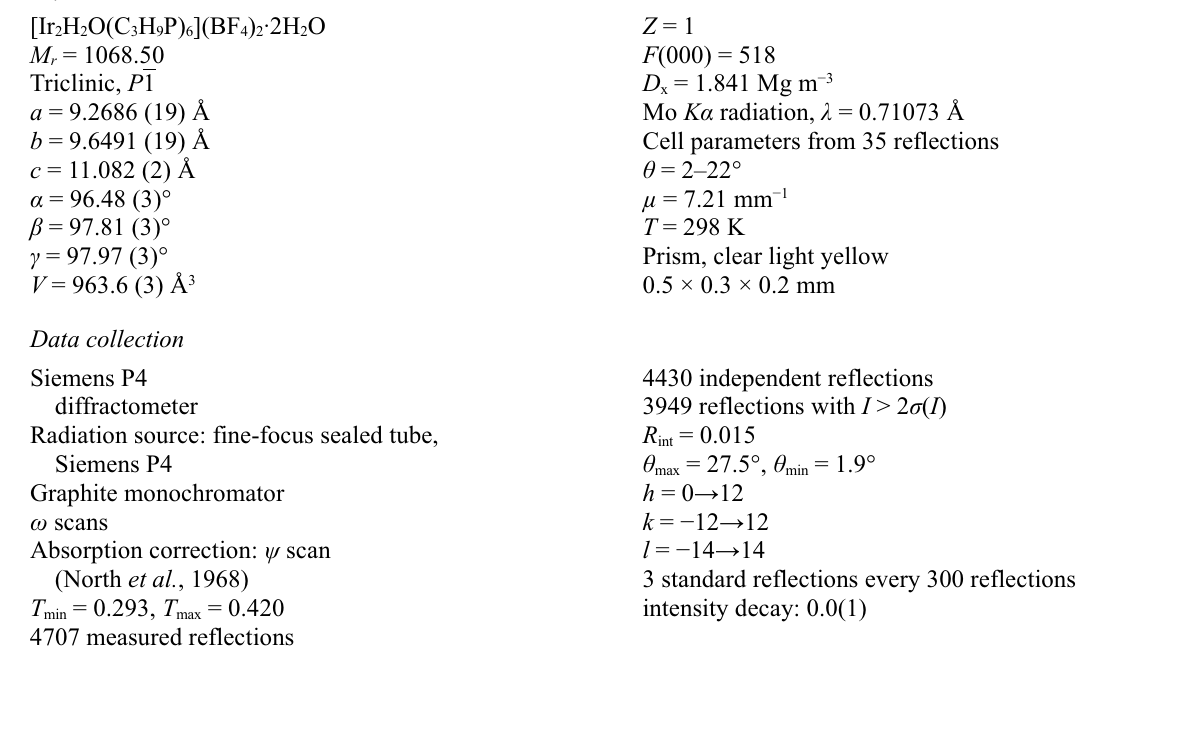
Figure 2 The hydrogen-bonding between water and the tetrafluoroborate anion in the title compound. Ellipsoids are drawn at the 50% probability level and atoms are labeled with supercripts to indicate the symmetry operator that generated them. A 1 : – X ,-Y,2- Z , A 2 : 1- X ,1-Y,1- Z , A 3 : -1+ X ,+Y,1+ Z , A 4 : 1- X ,-Y,1- Z . µ -Oxido-bis[hydridotris(trimethylphosphane- κ P )iridium(III)]( Ir — Ir ) bis(tetrafluoridoborate) dihydrate Crystal